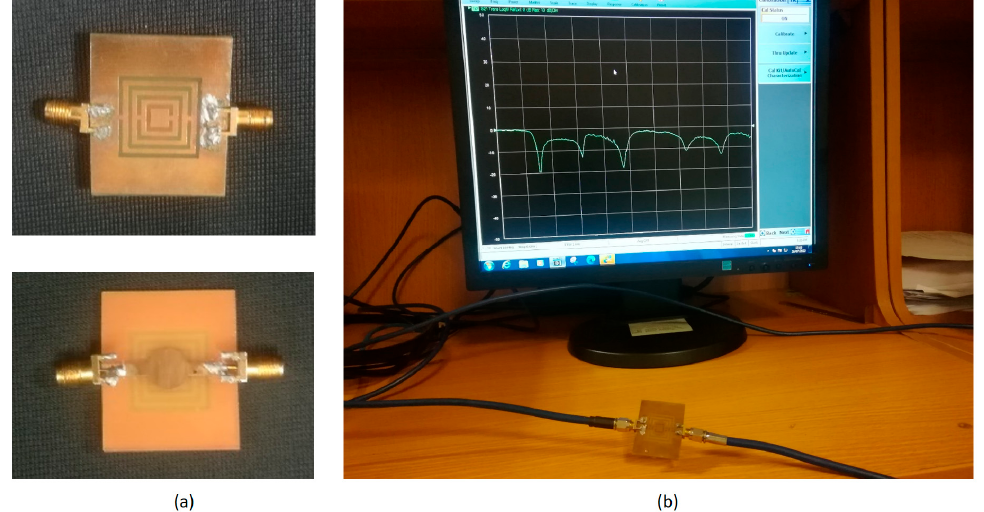
Figure 2. ( a ) Simulated and experimental values of transmission coefficient (S 21 ) at different frequencies. ( b ) Equivalent LC model of the CSRR sensor. ( c ) Electric field profile at the resonance frequency.